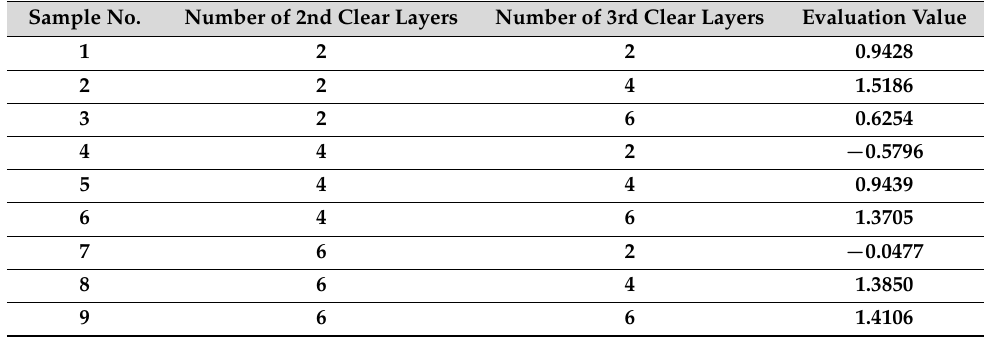
Table 3. Evaluation results for the thickness of clear layers. Sample